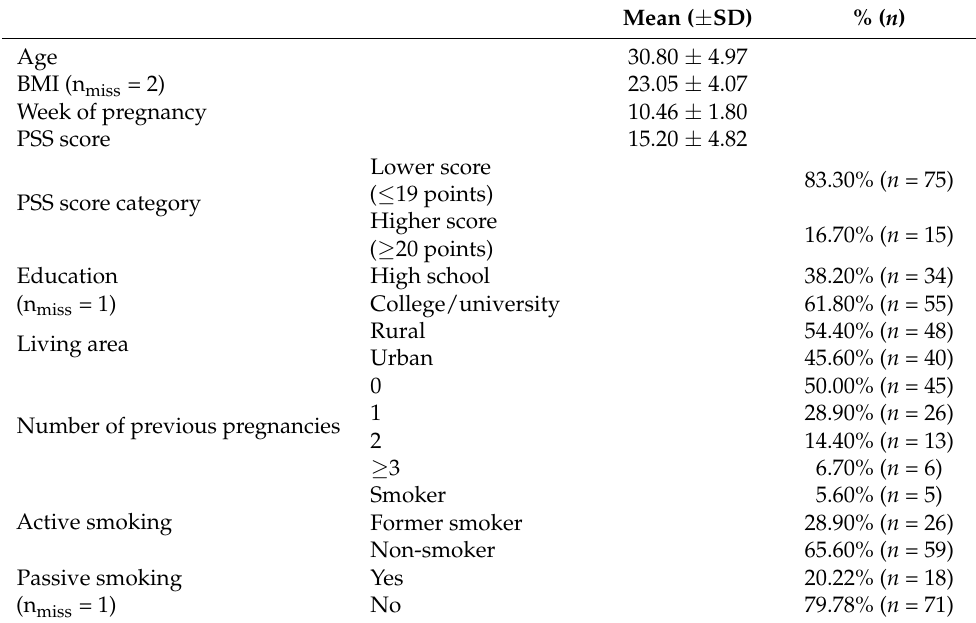
Table 1. Characteristics of the cohort based on demography and perceived stress ( n = 90).